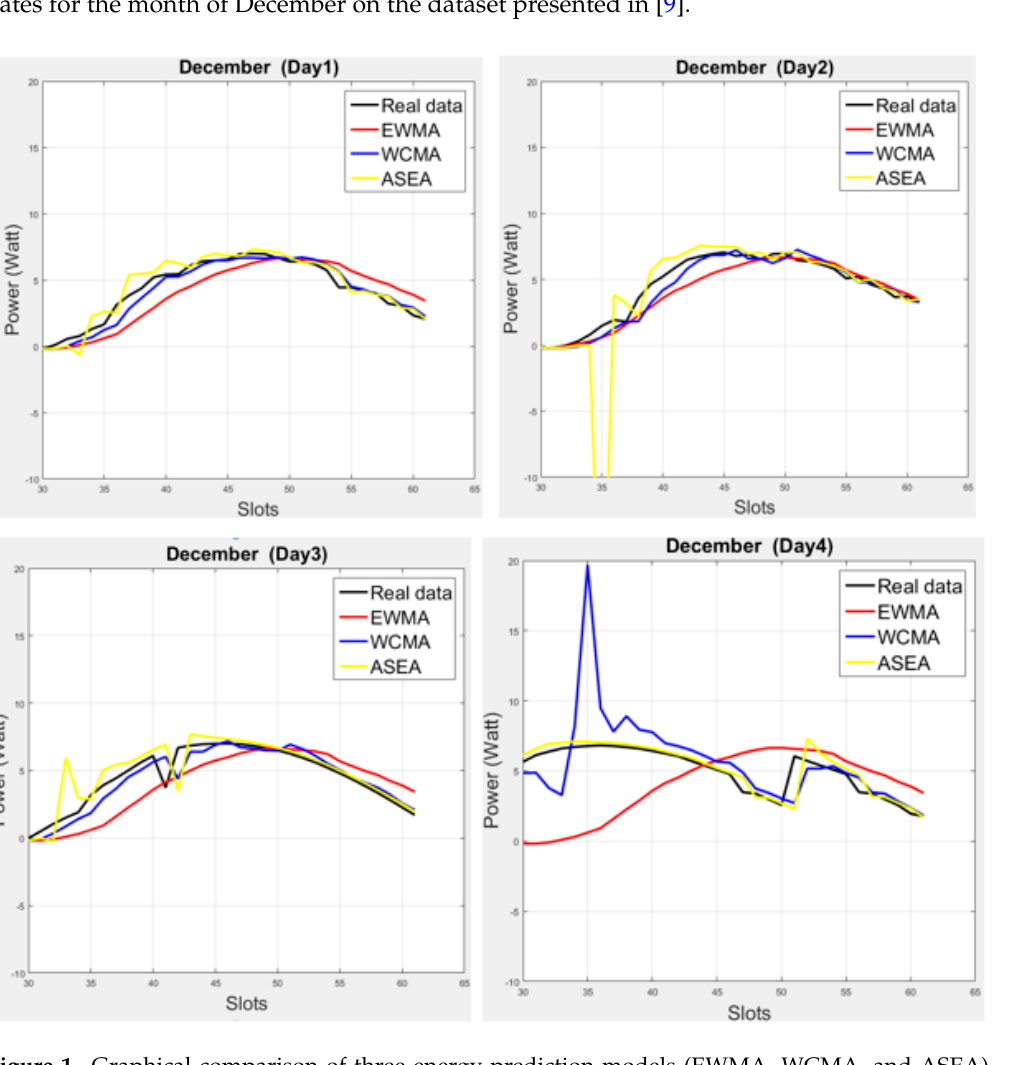
Figure 1. Graphical comparison of three energy prediction models (EWMA, WCMA, and ASEA) with real solar energy data for four different days in December. While the three models can follow the general trend of the real data, none of them can deal with all illumination variations due to inconsistent weather conditions.